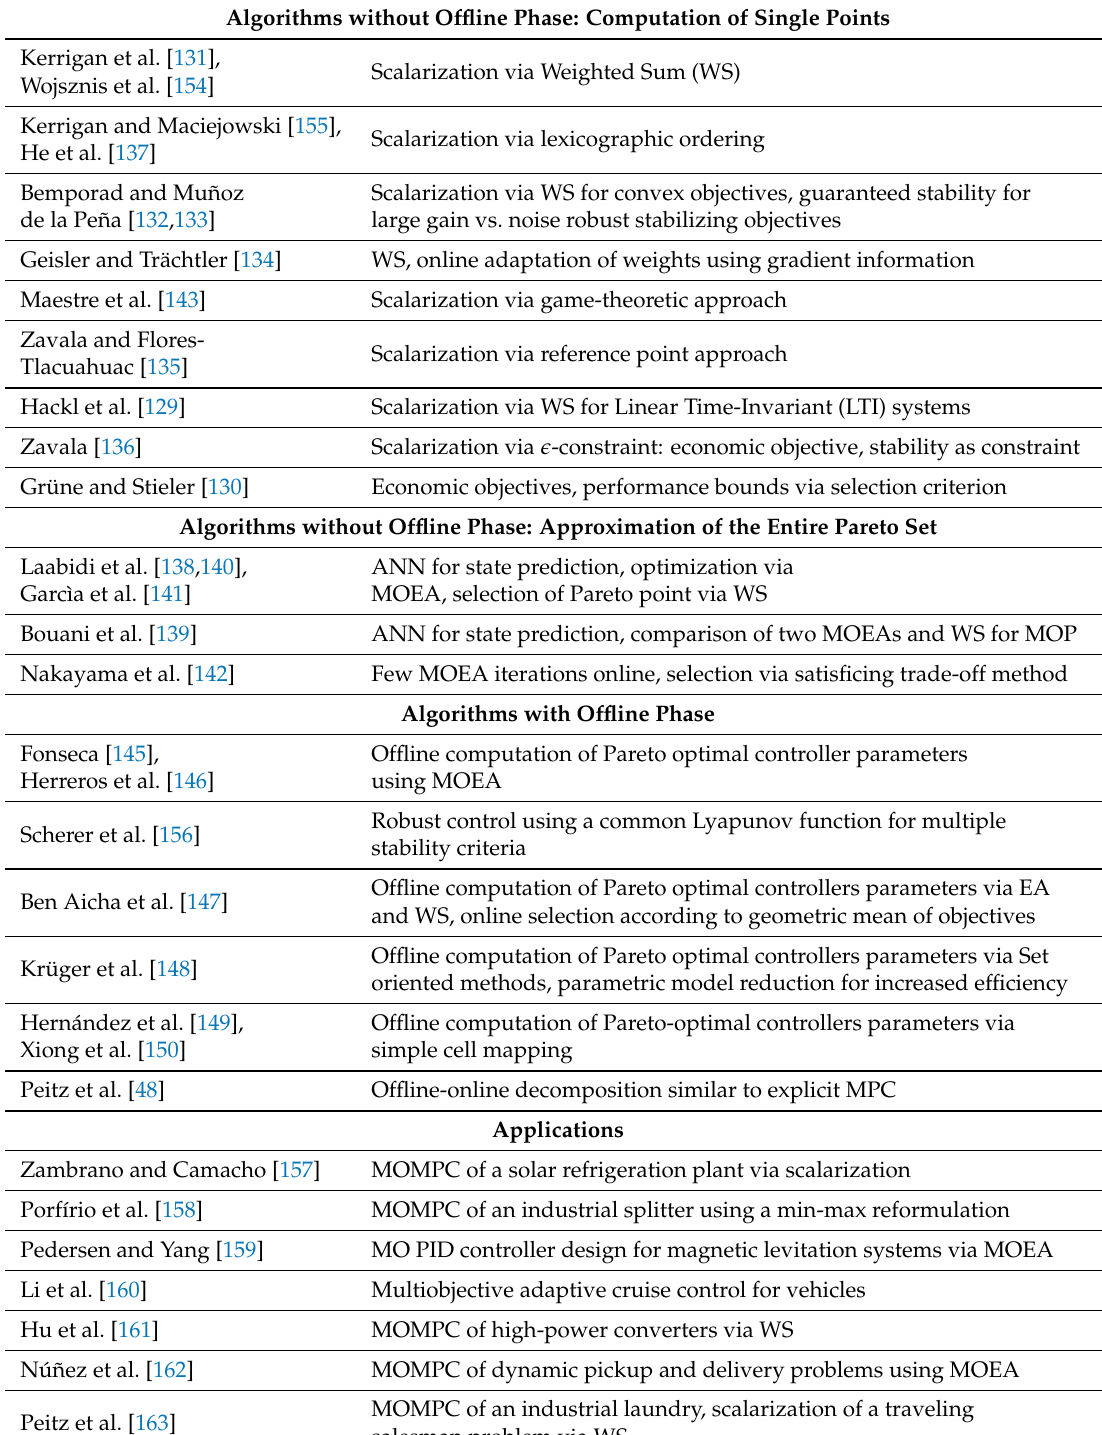
Table 2. Overview of publications (in chronological order) for multiobjective feedback